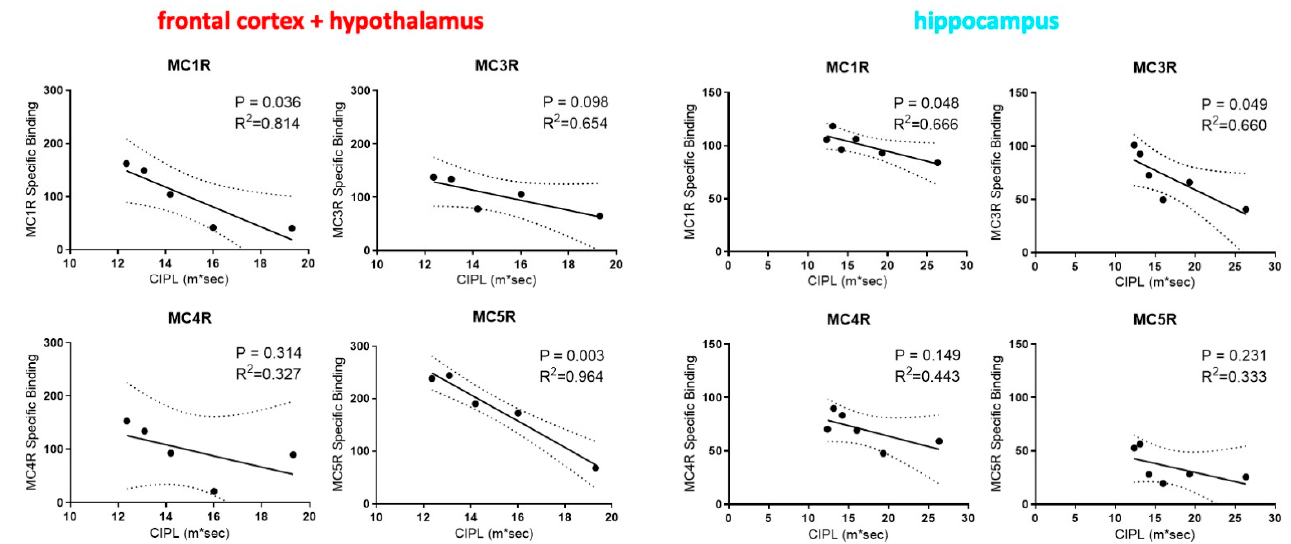
Figure 4. Linear correlations between the expression levels of different melanocortin receptor subtypes in the hippocampus and the frontal cortex/hypothalamus regions in the brains of aged (23 mo) rats and their performance in spatial learning and memory as measured by the Correlated Integrated Path Length (CIPL) in the Morris swim task.